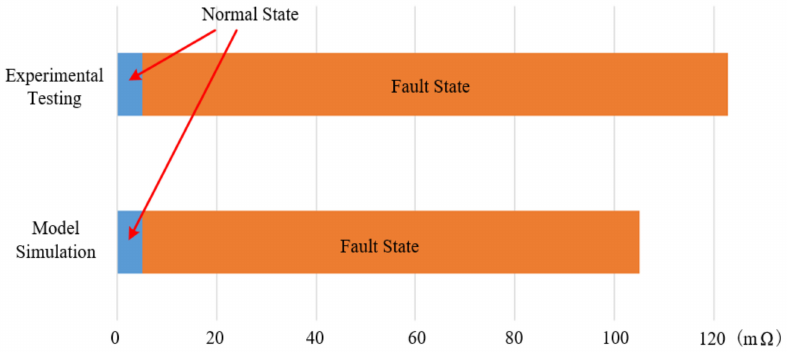
Figure 7. The normal and fault values of the connection resistance of solder balls in the experimental testing and model simulation.